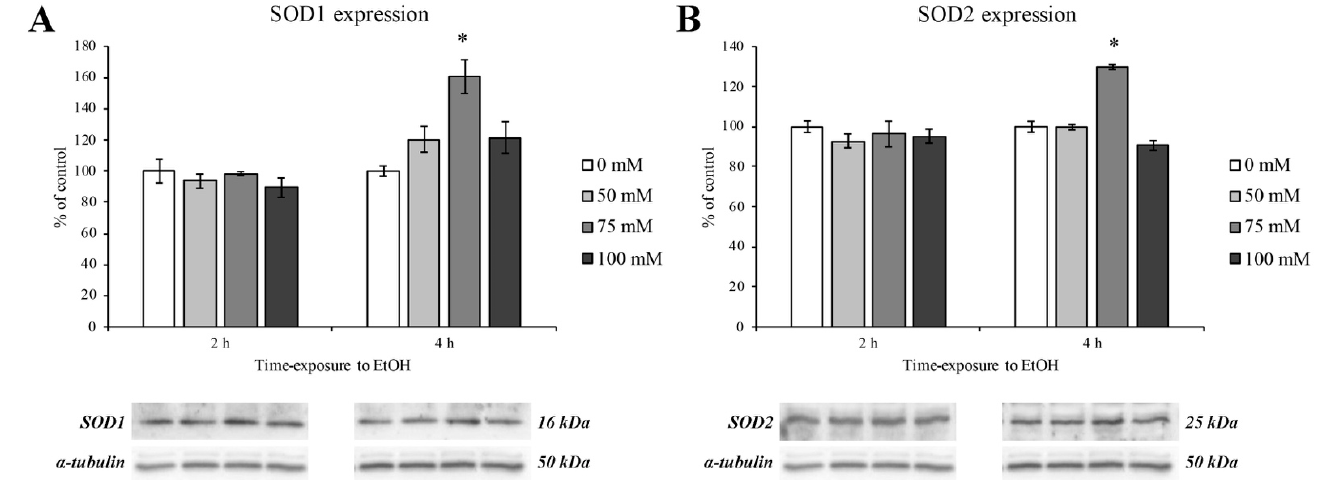
Figure 7. SOD1 and SOD2 expression levels on RBE4 cells after EtOH treatment. Western blotting analysis and quantification of SOD1 (panel A ) and SOD2 (panel B ) protein expression levels during EtOH (50, 75 and 100 mM) treatments at 2 and 4 h. Values are expressed in percentage of control (untreated cells) as the mean ± S.E.M. of three independent experiments in triplicate. * p < 0.05 vs. control.